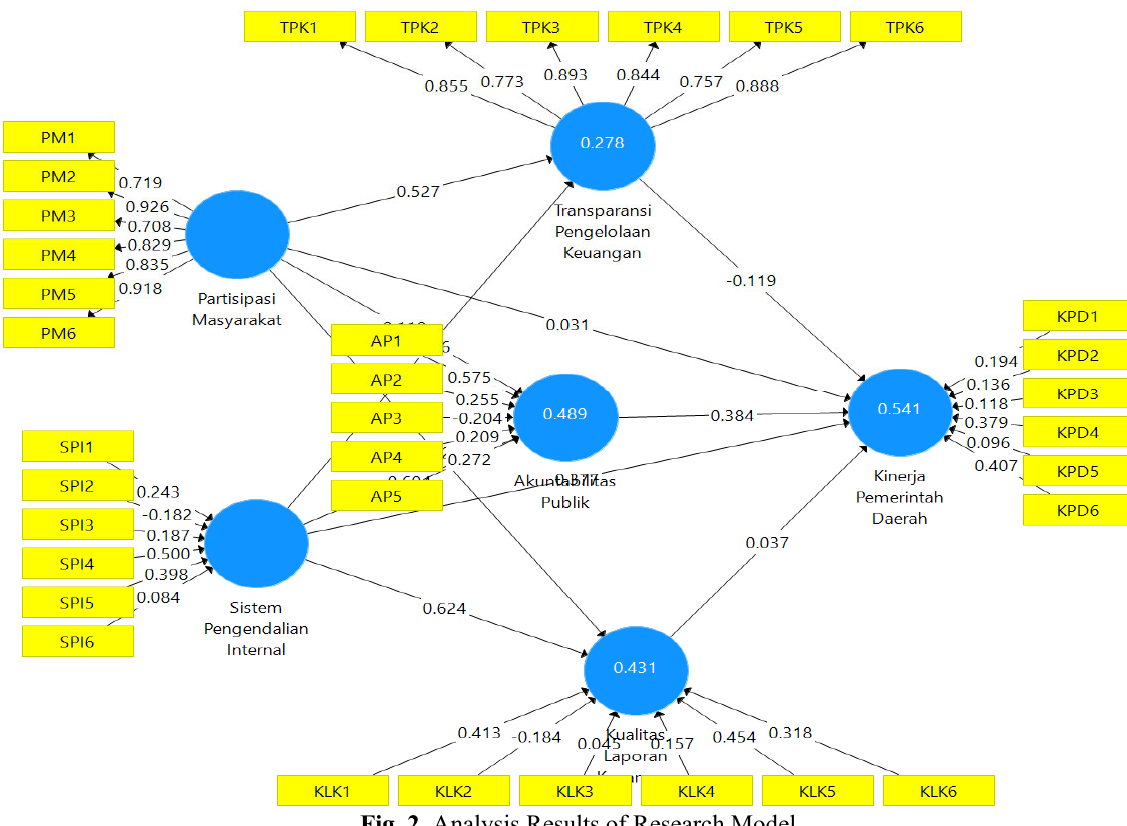
Fig. 2. Analysis Results of Research